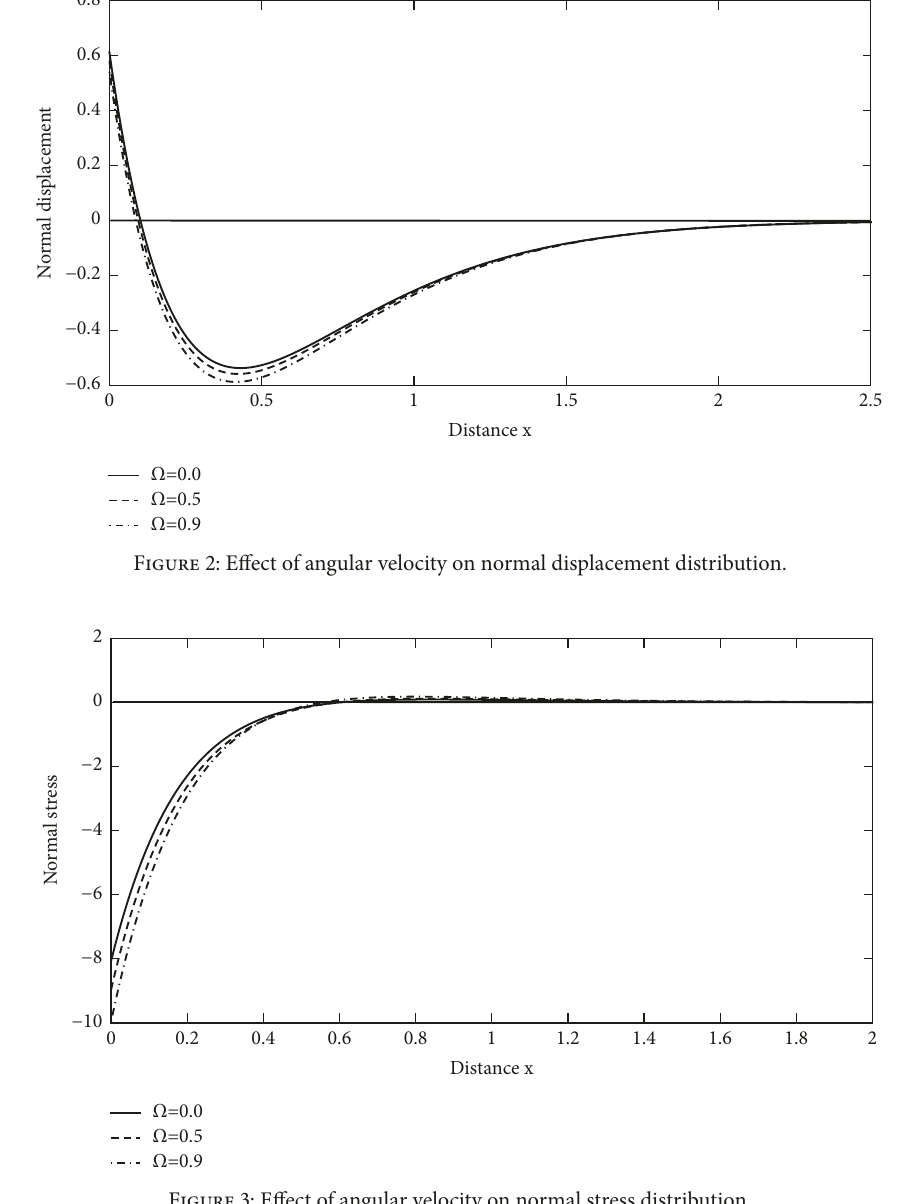
Figure 3: Effect of angular velocity on normal stress